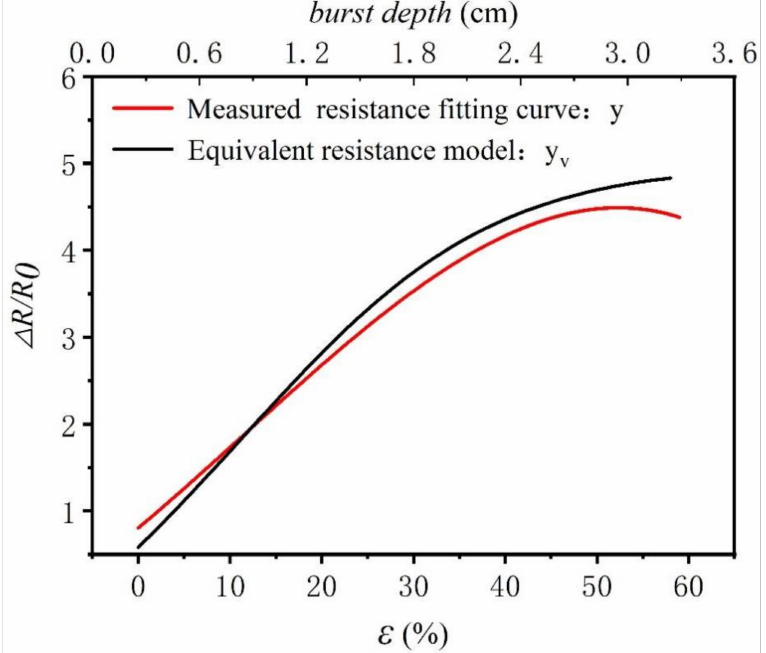
Figure 11. The theoretical model of equivalent resistance and the results of the burst test when the three-dimensional surface was